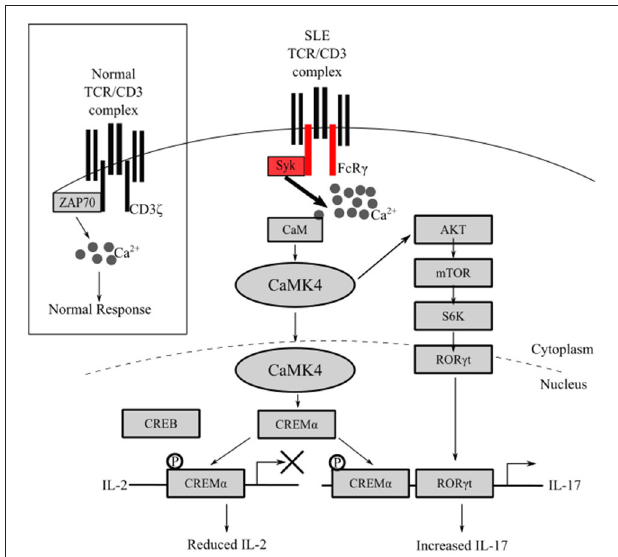
FIGURE 1 | Overactive CaMK4 in T cells signals to reduce IL-2 and increase IL-17 production. In patients with SLE, FcR γ , instead of CD3 ζ , associates with the TCR complex and signals through Syk generating a stronger calcium signal. Overactive CaMK4 phosphorylates CREM α and mitigates IL-2 transcription. Concomitantly, CaMK4 promotes IL-17 production through activation of ROR γ t by phosphorylating AKT.